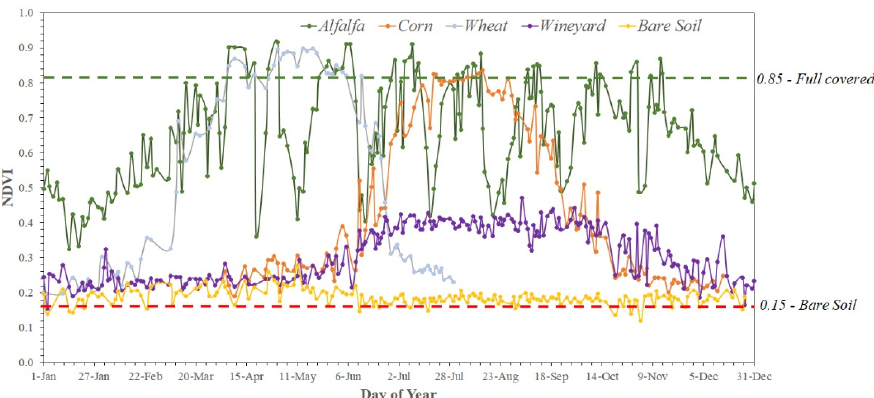
Figure 2. Time series of NDVI values from the Sentinel 2 and Landsat 8 joint constellation, accessible from the WebGIS platform (www.spiderwebgis.com, accessed on 1 March 2022), over different crops located in Albacete (Spain) gathered between 2014 and 2018. The green dashed line highlights the full vegetated cover and the red dashed line indicates bare soil.